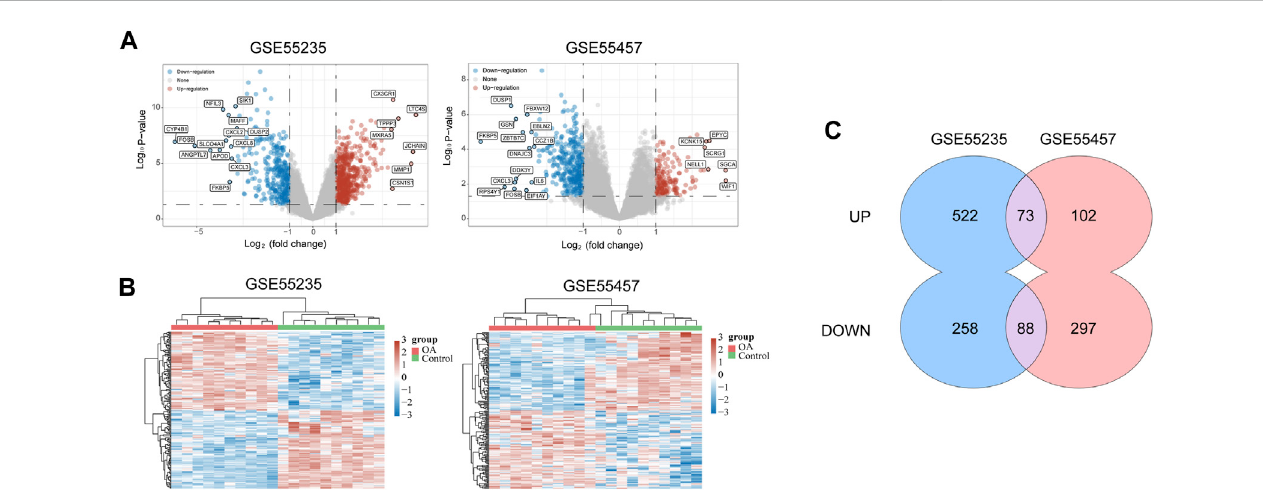
FIGURE 2 Data collection and identi fi cation of DEGs. (A) Volcano plot of DEGs in two datasets ( p < 0.05 and log2|FC| ≥ 1). The red nodes represent up-regulated genes, and the blue nodes represent down-regulated genes. (B) Heat map of DEGs in two datasets, in which different colors represent different expression trend. Due to the large number of DEGs, the top 50 up-regulated and down-regulated genes with the largest FC were shown. (C) Venn diagram of two datasets which showed up-regulated and down-regulated genes respectively. DEGs = differentially expressed genes; FC = fold change.